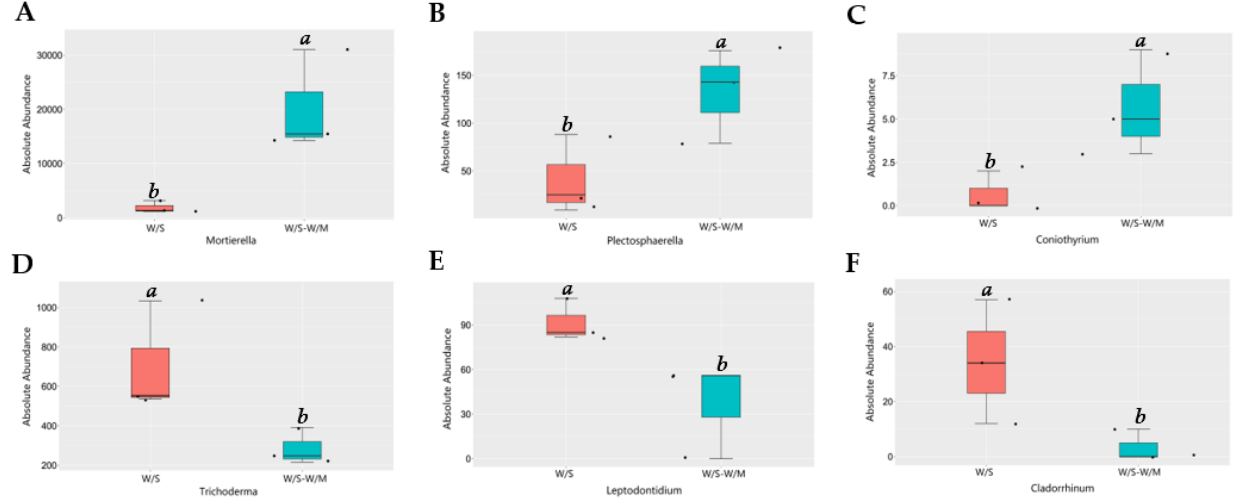
Figure 5. Relative abundance of potentially beneficial fungi in two cropping systems. Different letters above columns signified statistically significant difference ( p < 0.05) according to MetaStat anal- ysis. The dots represent three replicates for each treatment. W/S, continuous wheat/soybean cropping system; W/S-W/M, wheat/soybean-wheat/maize rotation system. ( A )- Mortierella ; ( B )- Plectosphaerella ; ( C )- Coniothyrium ; ( D )- Trichoderma ; ( E )- Leptodontidium ; ( F )- Cladorrhinum .